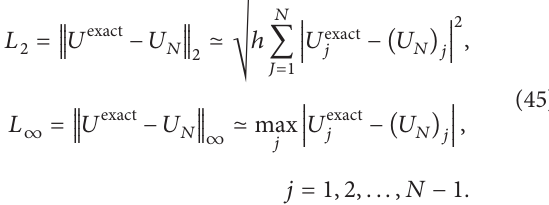
time steps Δ𝑡 = 0.01, 0.001 over the interval 0 ≤ 𝑥 ≤ 1